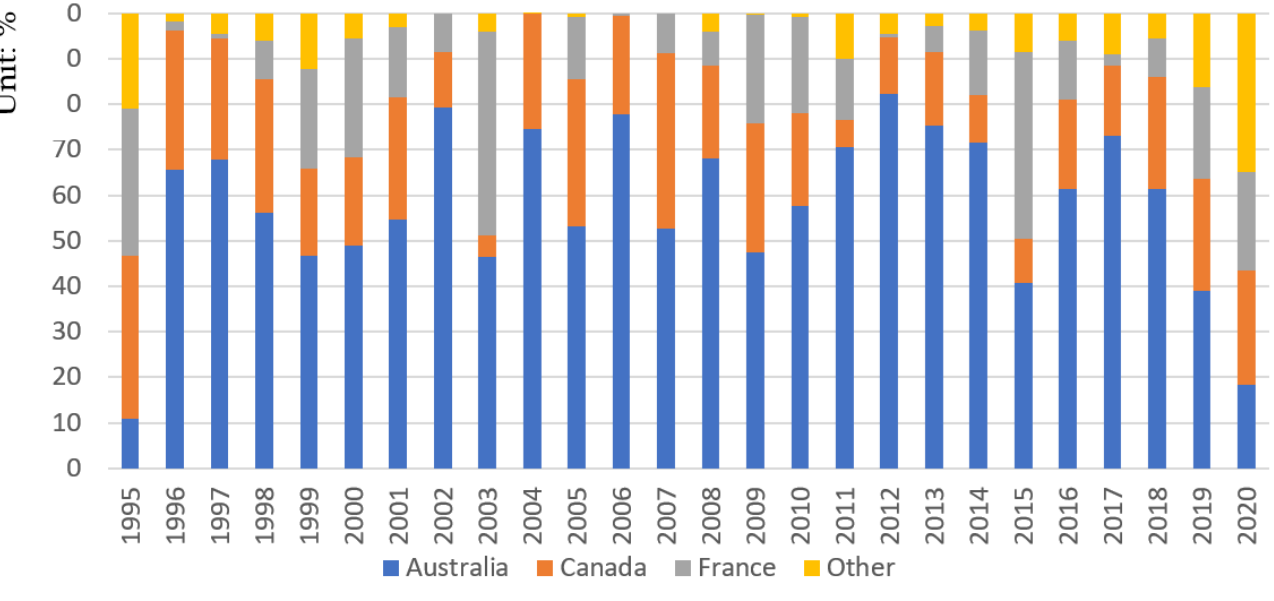
Figure 1. Changes in import proportion of major exporting countries of barley in China from 1995 to 2020 (unit: %).